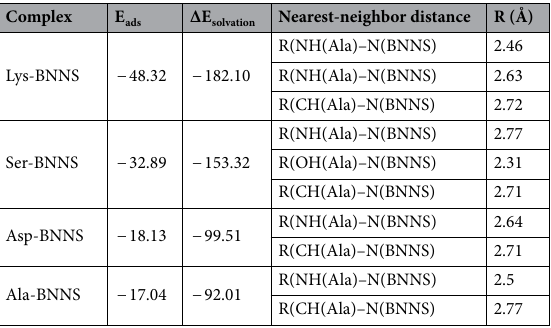
Table 2. Amino acid-conjugated BNNS in the solvated phase: adsorption energy Eads, solvation energy ΔE solvation (all in kJ/mol), nearest-neighbor distance of different complexes obtained using the DFT (M06-2X/6- 31G**) level of